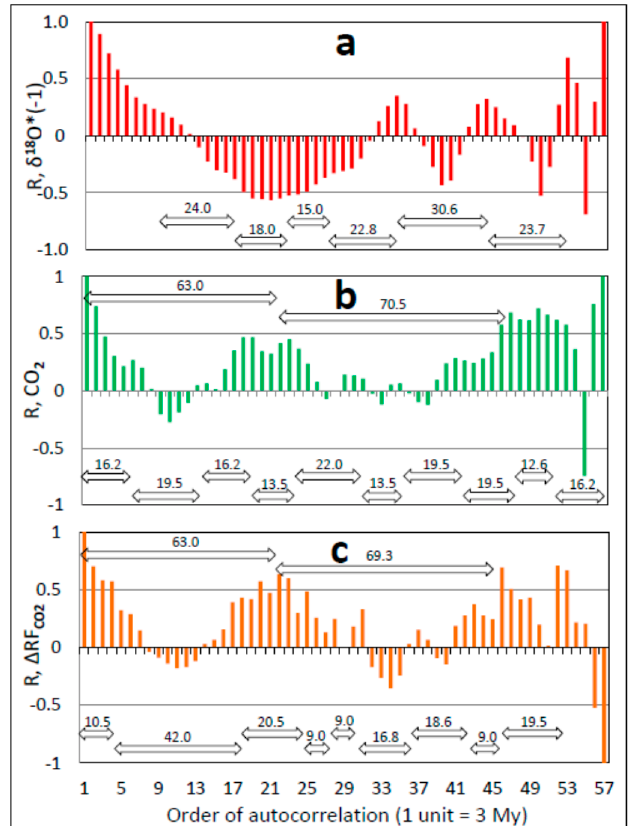
Figure 12. Lagged (serial) autocorrelation coefficient, R , of time series of Phanerozoic climate variables over the time period from 174 to 0 Mybp. The periodicity in the autocorrelation profiles demonstrates non-random periodicity in the corresponding climate variables. ( a ) δ 18 O*( − 1). Average cycle duration, 22.4 My. ( b ) Atmospheric CO 2 concentration. Average short cycle, 16.9 My. Average long cycle, 66.8 My. ( c ) Δ RF CO2 . Average short cycle, 17.2 My. Average long cycle, 66.2 My. Double-headed arrows demarcate the approximate times of cycles and sub-cycles identified visually.